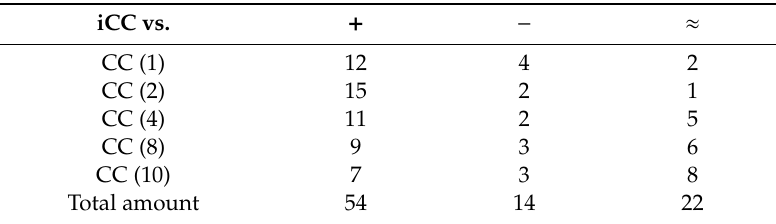
Table 6. Mann–Whitney U test, pop_size is 100.